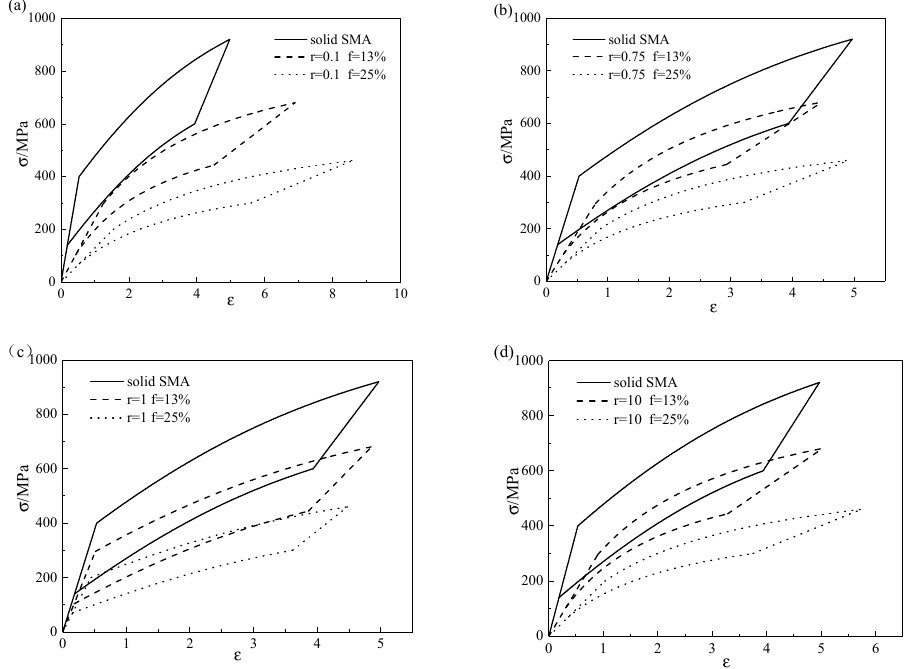
Figure 7. Stress–strain curves of different porosities with aspect ratios of ( a ) r = 0.1, ( b ) r = 0.75, ( c ) r = 1, and ( d ) r = .